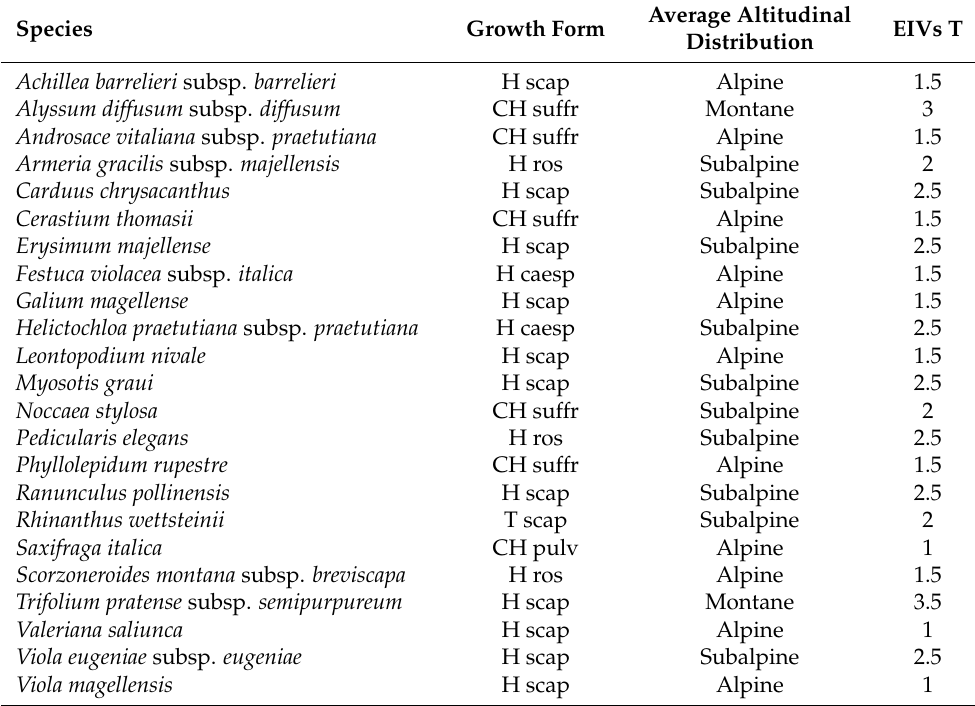
Table 1. Endemic species present in the analyzed alpine plant communities along with their rel- ative growth form ( sensu Pignatti et al. [74]), average altitudinal distribution of the species, and species’ ecological indicator value for temperature (EIVs T) sensu Landolt [75]. CH pulv: pulvinate chamaephytes; CH suffr: suffruticose chamaephytes; H caesp: caespitose hemicryptophytes; H ros: hemicryptophytes with rosette; H scap: scapose hemicryptophytes; and T scap: scapose therophytes. Average Altitudinal EIVs T Species Growth Form Distribution Achillea barrelieri subsp. barrelieri H